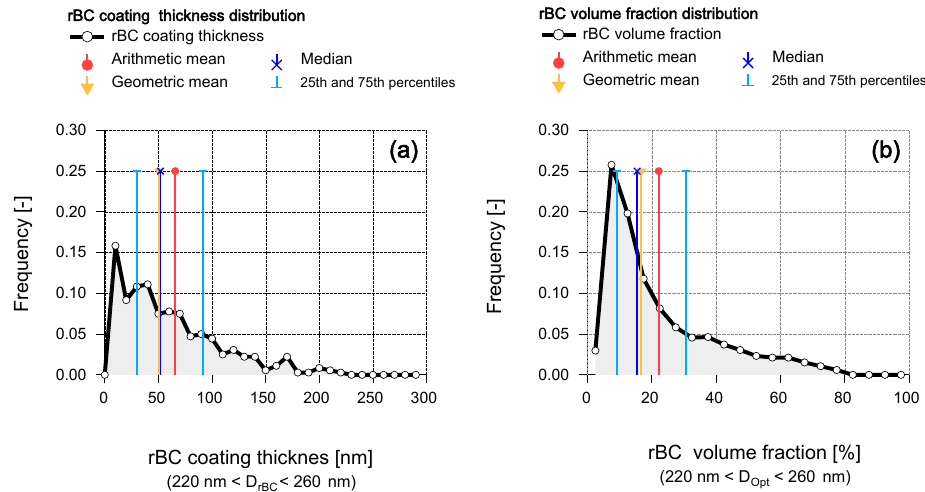
Figure 4. Frequency distributions of single-particle properties inferred from the SP2 measurement during the whole campaign: (a) BC coating thickness of BC cores with 220nm <D rBC < 260nm; (b) rBC volume fraction distribution of BC-containing particles having an optical diameter between 220 and